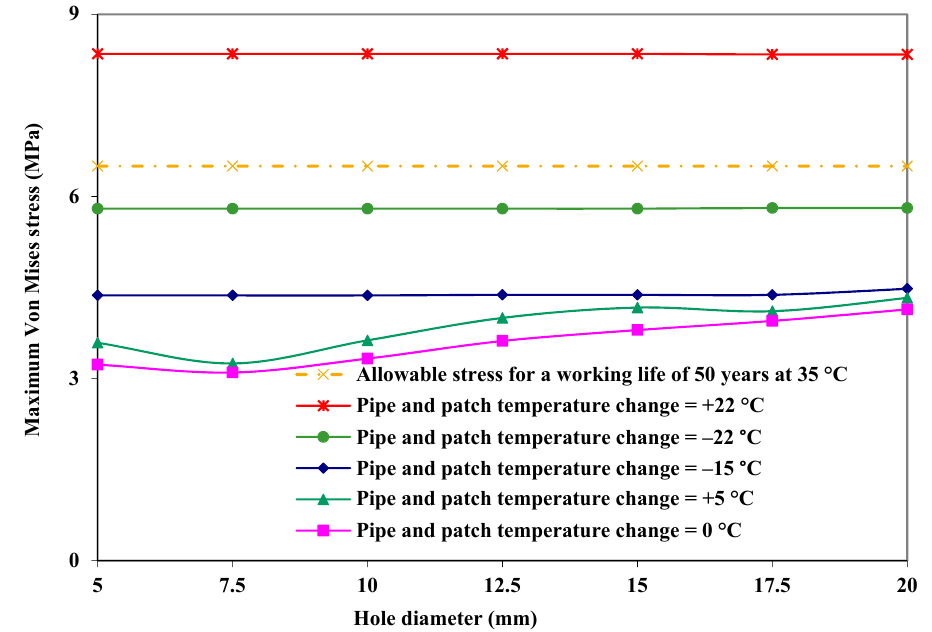
Figure 12. Maximum Von Mises stress in the semi-cylindrical patch for various sizes of circular hole defects (the simultaneous effect of mechanical and thermal loads).